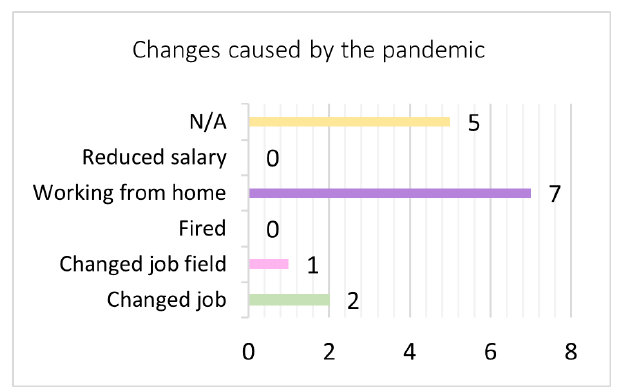
Figure 7. Changes caused by the pandemic.